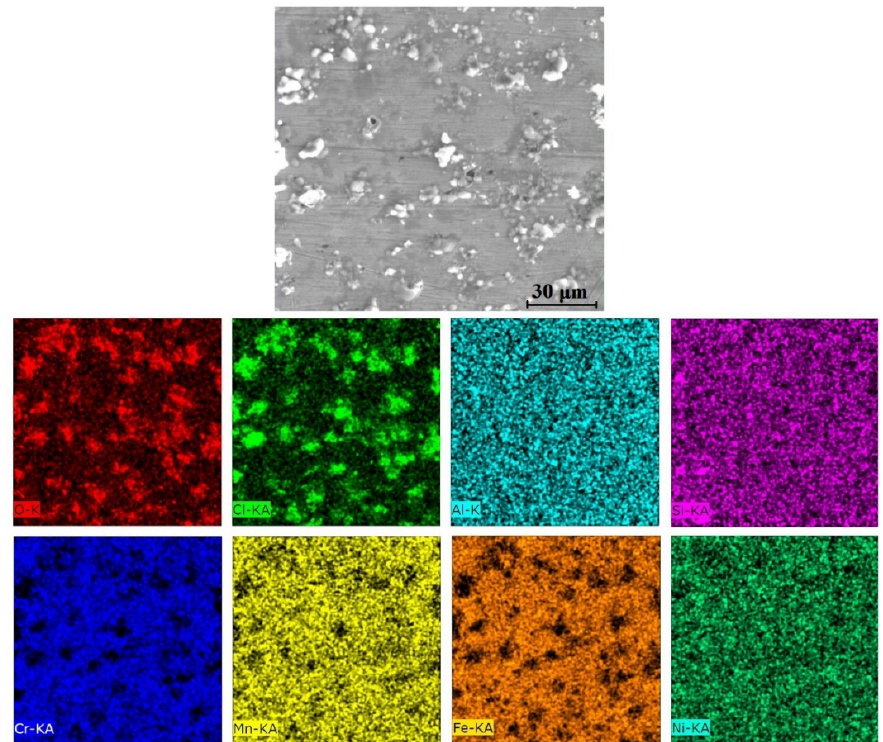
Figure 18. EDX elemental mapping of the corroded cold-rolled Fe 36 Mn 20 Ni 20 Cr 16 Al 5 Si 3 HEA in 0.6 M NaCl with 1 M H 2 SO 4 .